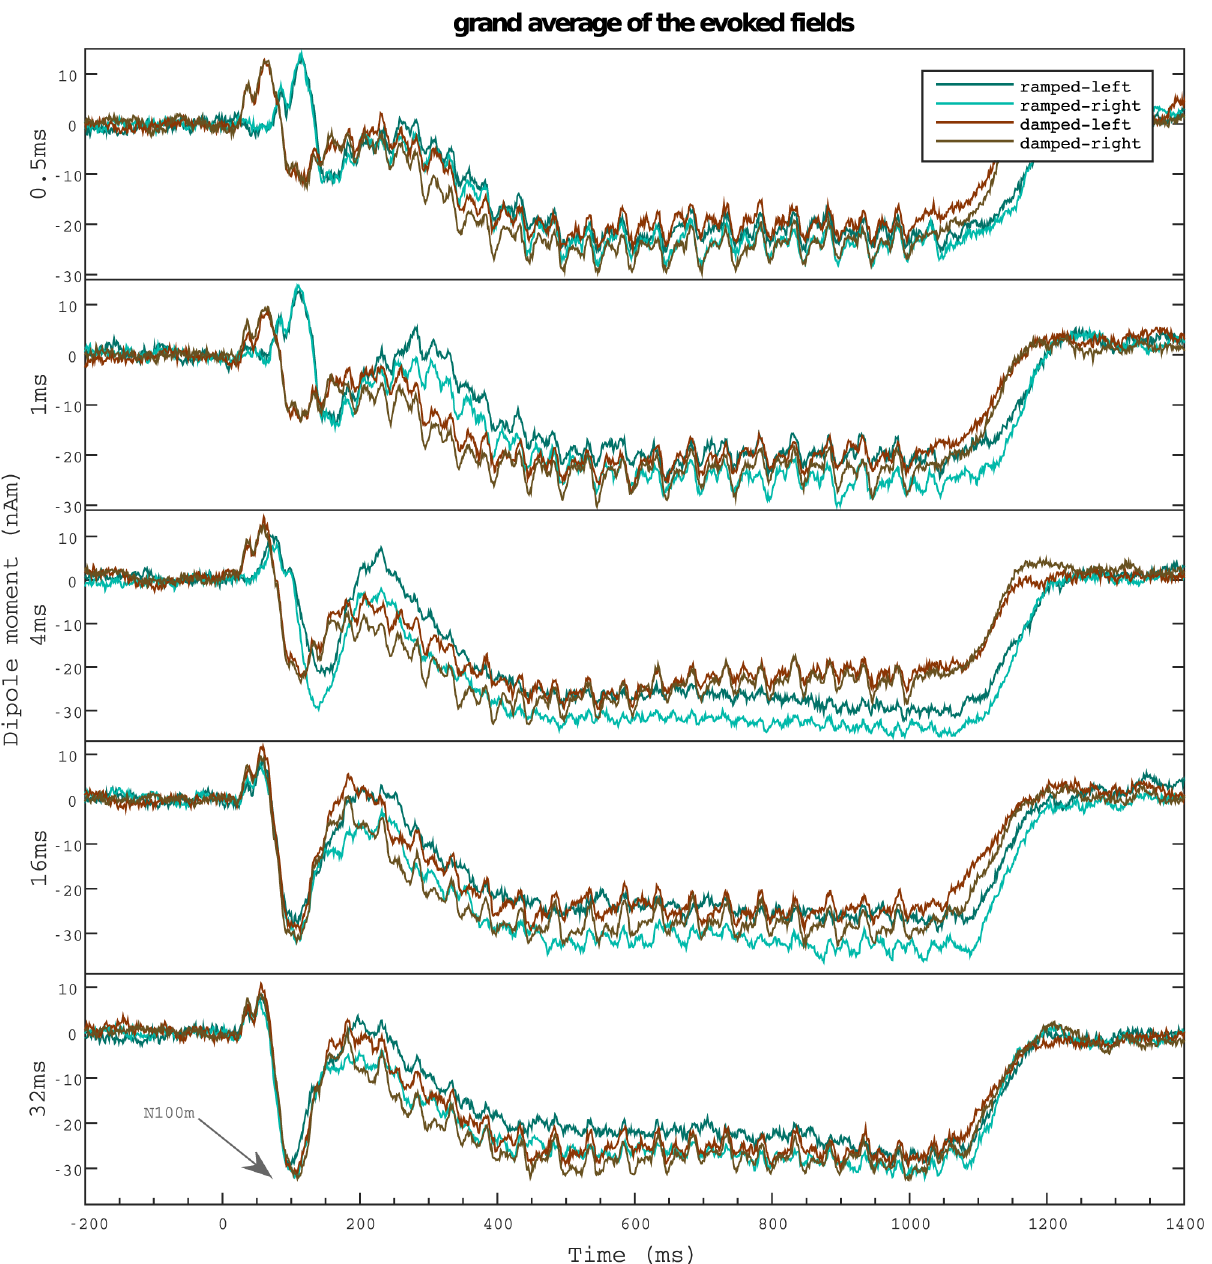
Fig 5. Auditory fields evoked by the ramped and damped sinusoids. Grand mean source waveforms for the five different conditions of ramped and damped sinusoids. Average was taken over subjects ( n = 27) for both hemispheres. The magnitude of the N100m increases for rising T 1/2 values of the stimuli. Note the maximal difference between ramped and damped sinusoids in the right hemisphere for the T 1/2 = 4ms